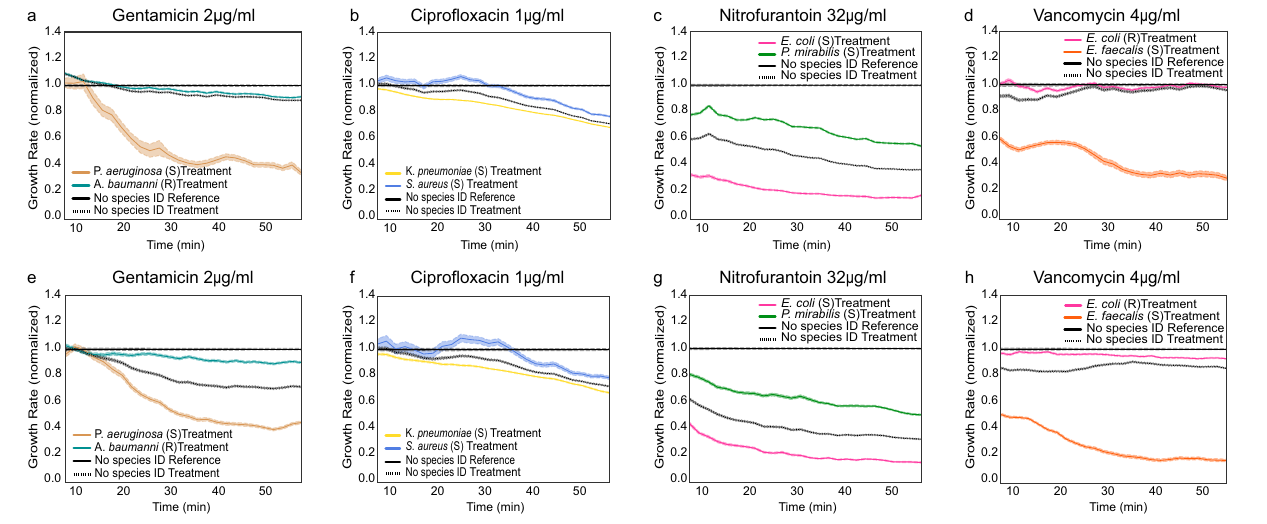
Fig. 5 | Species-wise AST pro fi les for experiments with 2 species using the combinatorial FISH method. a P. aeruginosa and A. baumannii were treated with Gentamicin, b K. pneumoniae , and S. aureus treated with Cipro fl oxacin, c E.coli , and P.mirabilis treatedwithNitrofurantoin, d E.coli and E.faecalis treated